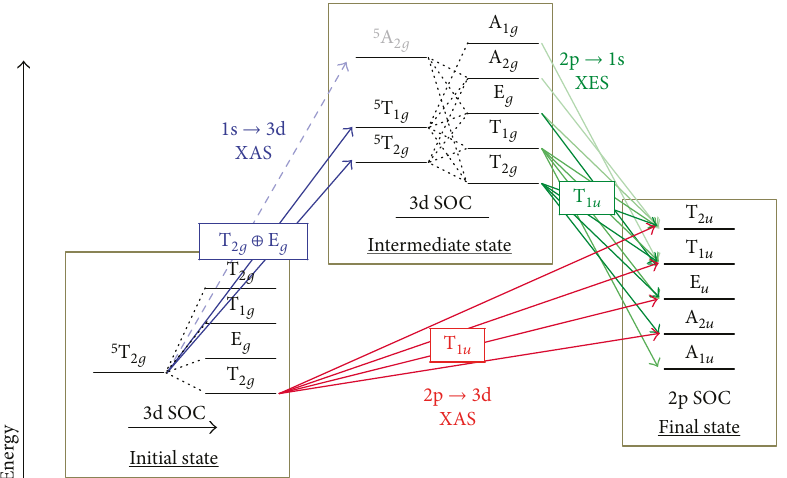
Figure 46: Multielectronic term scheme for Fe 2+ ( 3d 6 ) (high spin) comparing the 1s2p RIXS and 2p XAS pathways. Where SOC is considered, the spin multiplicity is omitted as its meaning is